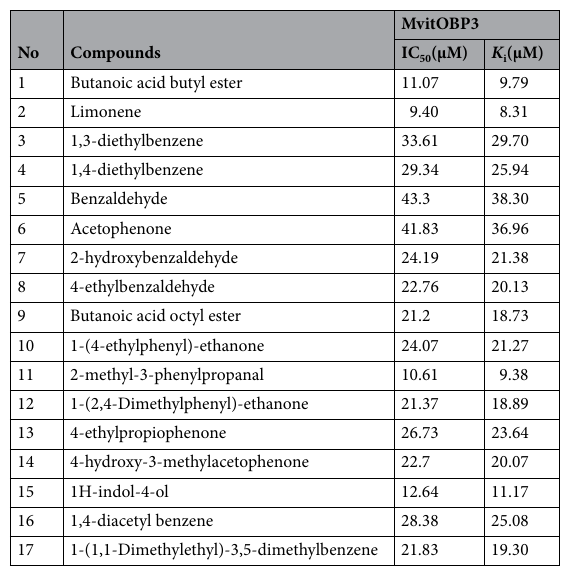
Table 2. The binding constants of different ligands. Binding of 1-NPN and different host-plant volatile ligands to MvitOBP3. Ki , dissociation constant; IC 50 , ligand concentration displacing 50% of the fluorescence intensity of the MvitOBP /N-phenyl-1-naphthylamine complex.